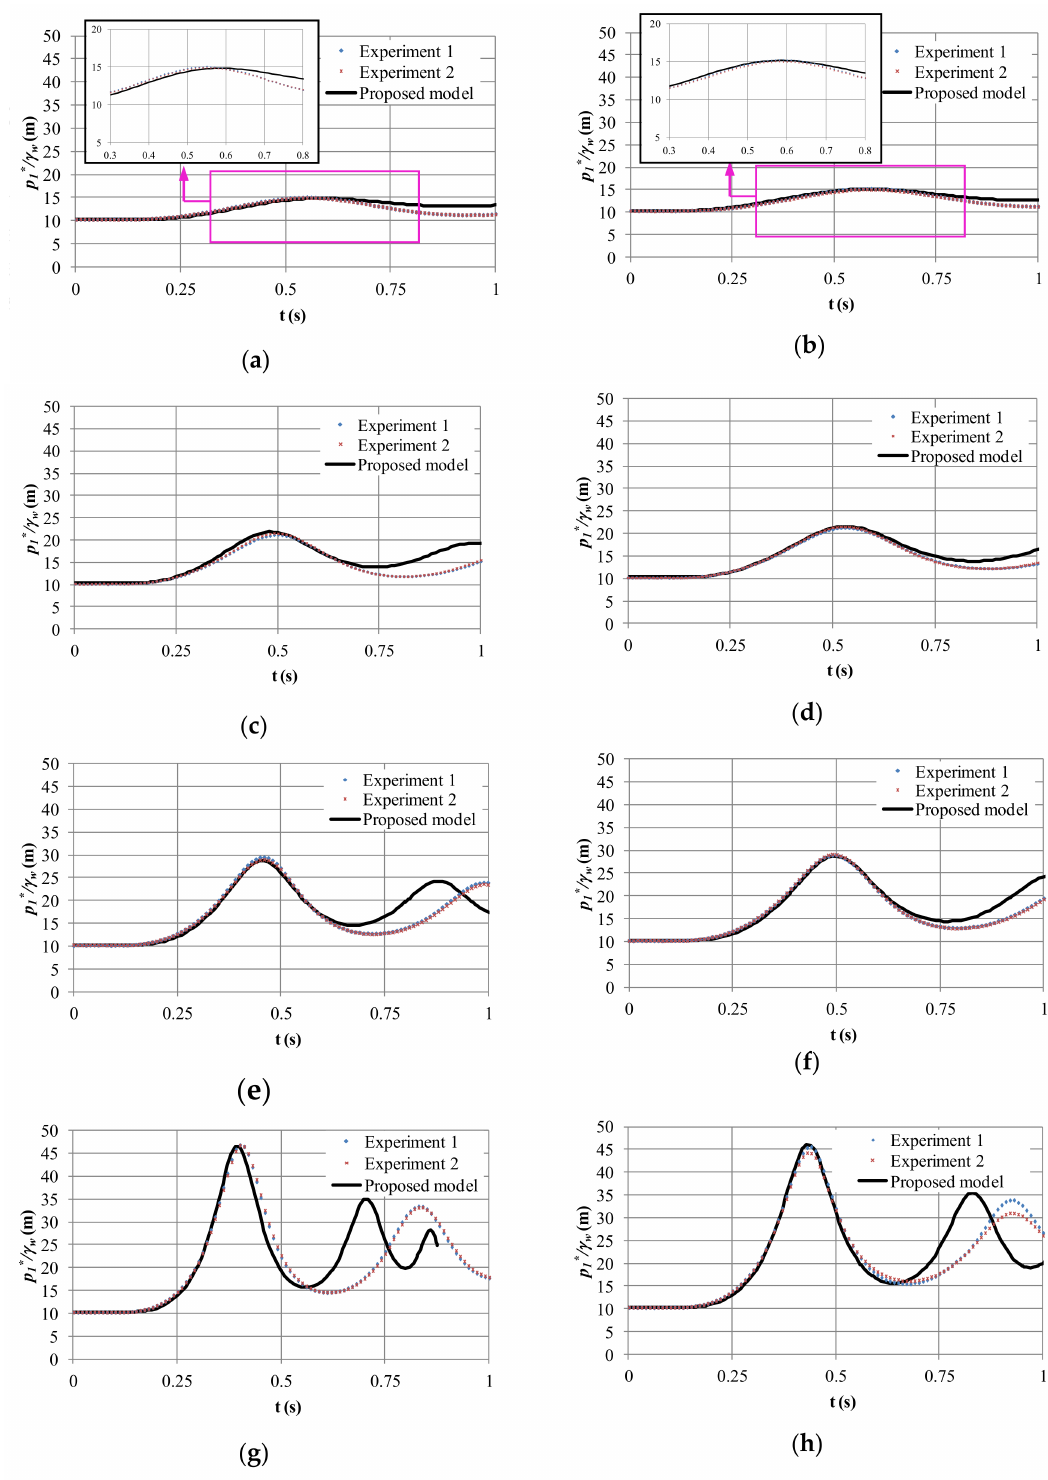
Figure 4. Air pocket pressure patterns: ( a ) Test No. 1; ( b ) Test No. 2; ( c ) Test No. 3; ( d ) Test No. 4; ( e ) Test No. 5; ( f ) Test No. 6; ( g ) Test No. 7; ( h ) Test No.